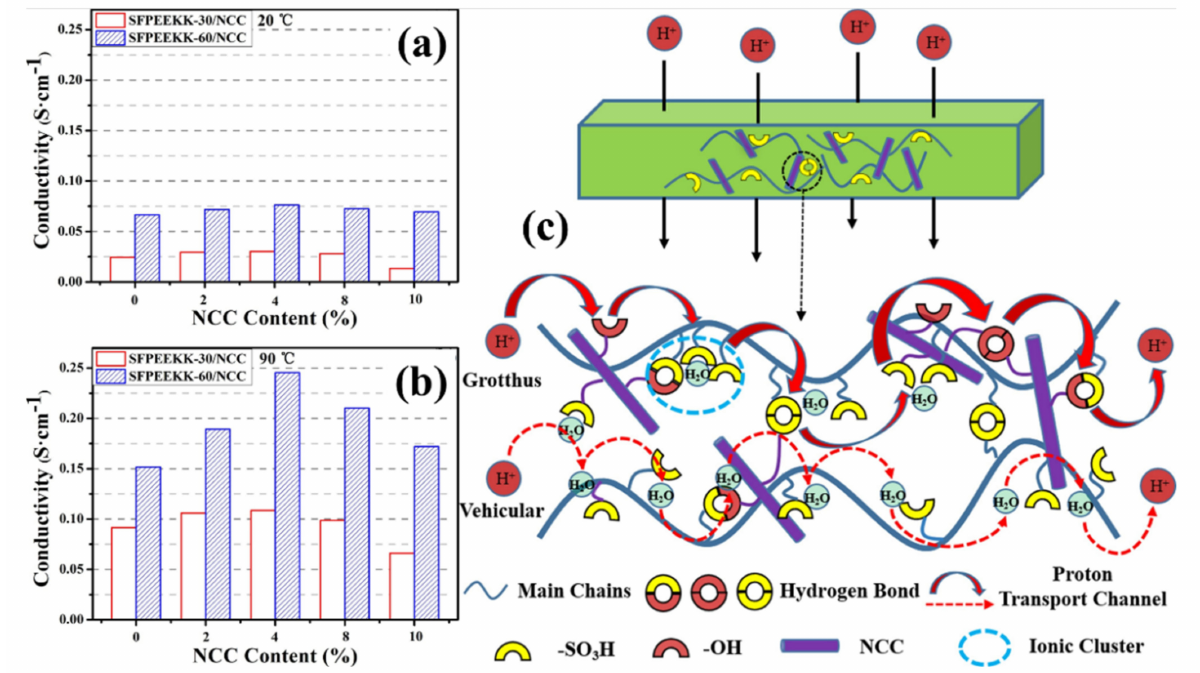
Figure 6. Proton conductivity of different concentrations of CNC and Sulfonated fluorenyl-containing poly(ether ether ketone ketone)s (SFPEEKKs) membranes at different temperatures ( a ) 20 ◦ C and ( b ) 90 ◦ C. ( c ) Illustration showing the CNC − SFPEEKK composites proton transport mechanism. Reprinted with permission from Ref. [117]. Copyright © 2017 Elsevier B.V. (License Number: